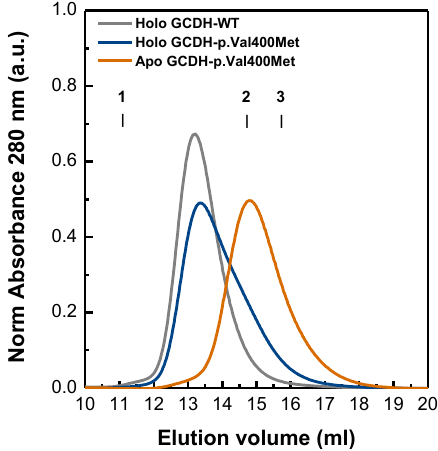
Figure 3. Size-exclusion chromatography of GCDH-WT and GCDH-p.Val400Met variant. Protein solutions were applied into a Superdex 200 10/300 GL column equilibrated in 10 mM HEPES pH 7.8, 150 mM NaCl. GCDH-WT—gray line, GCDH-p.Val400Met holoprotein—blue line, and GCDH-p.Val400Met apoprotein—orange line. Absorbance intensity at 280 nm was normalized in relation to total amount of protein applied. The elution volumes of ferritin (440 kDa), conalbumin (75 kDa), and ovalbumin (43 kDa) are also shown in the chromatogram as 1, 2, and 3, respectively.